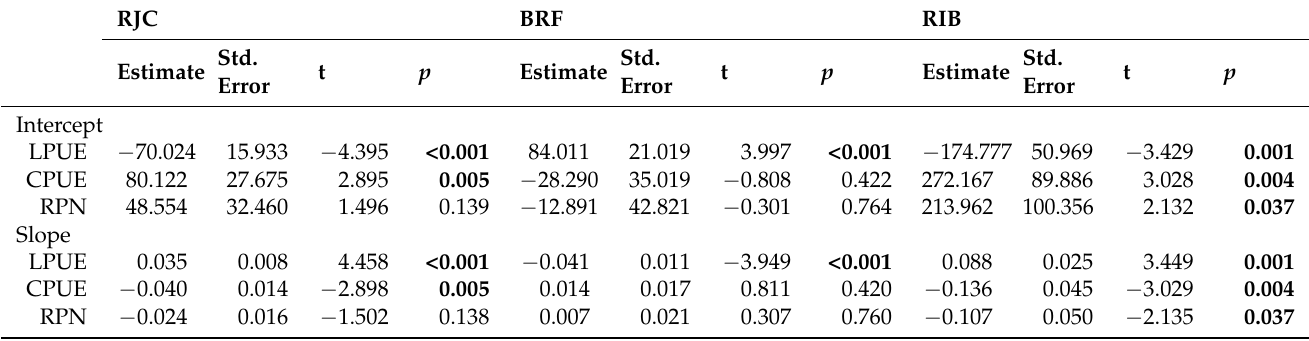
Table 2. Results of analysis of covariance (ANCOVA) for differences between regression lines